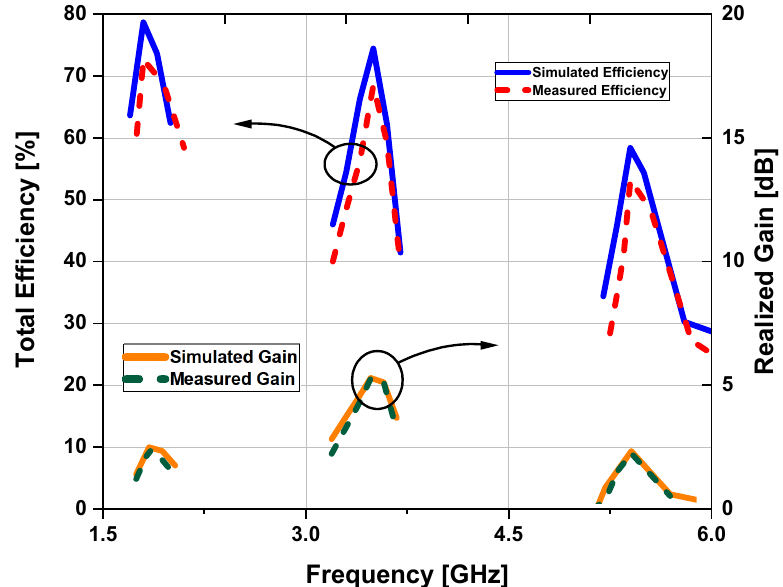
Figure 10. Simulated and measured gain and efficiency graph.